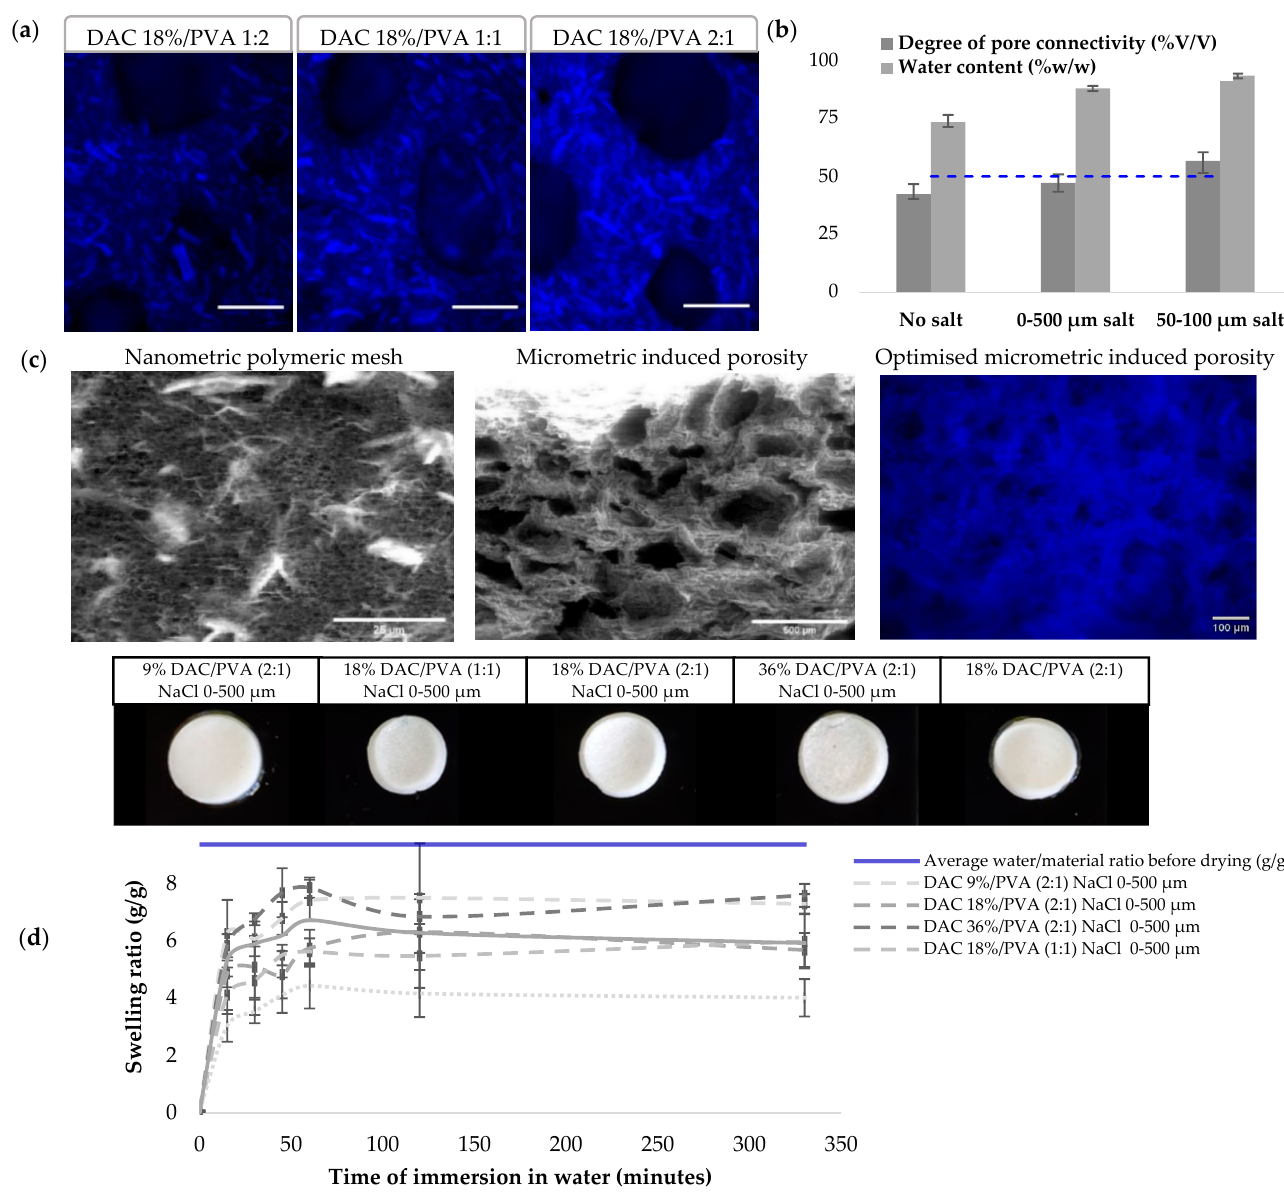
Figure 5. ( a ) Calcofluor white stained DAC 18%/PVA NaCl 0-500 µm scaffolds respectively at ratio 1:2, 1:1 and 2:1 showing cellulosic material (blue; scale bar: 250 µm); ( b ) Degree of pore connectivity (% v/v ) and water content (% w/w ) quantifications modulating salt leaching induced porosity (n = 5); ( c ) MEB observation of nano and micro porosities of DAC 18%/PVA (2:1) NaCl 0–500 µm scaffold; Calcofluor white stained DAC 9%/PVA (2:1) NaCl 50–100 µm showing enhanced porosity; ( d ) Swelling ratio study including photographs of rehydrated DAC/PVA based scaffolds.